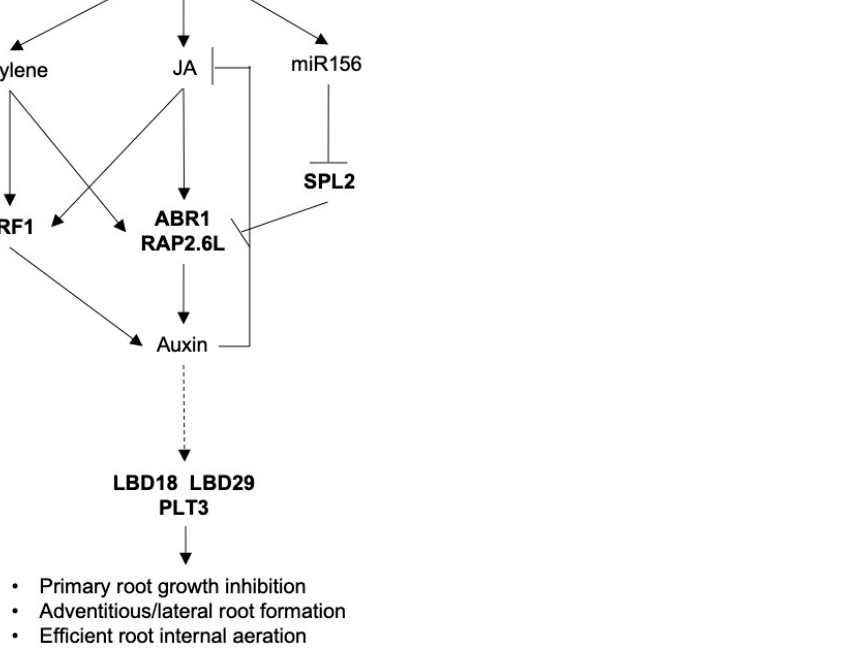
Figure 9. A proposed model of the molecular mechanism controlling WS-trigger root plasticity based on the transcriptome data.